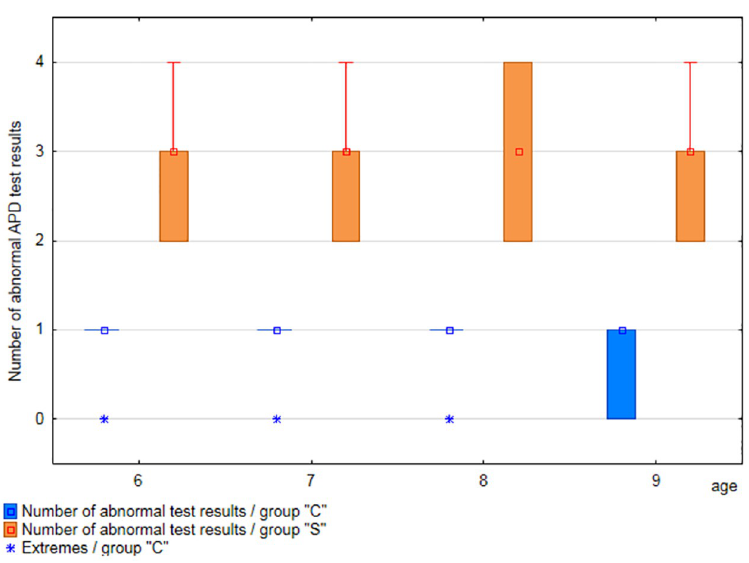
Fig 6. Comparison of the number of abnormal APD test with abnormal results in each study group, by age.